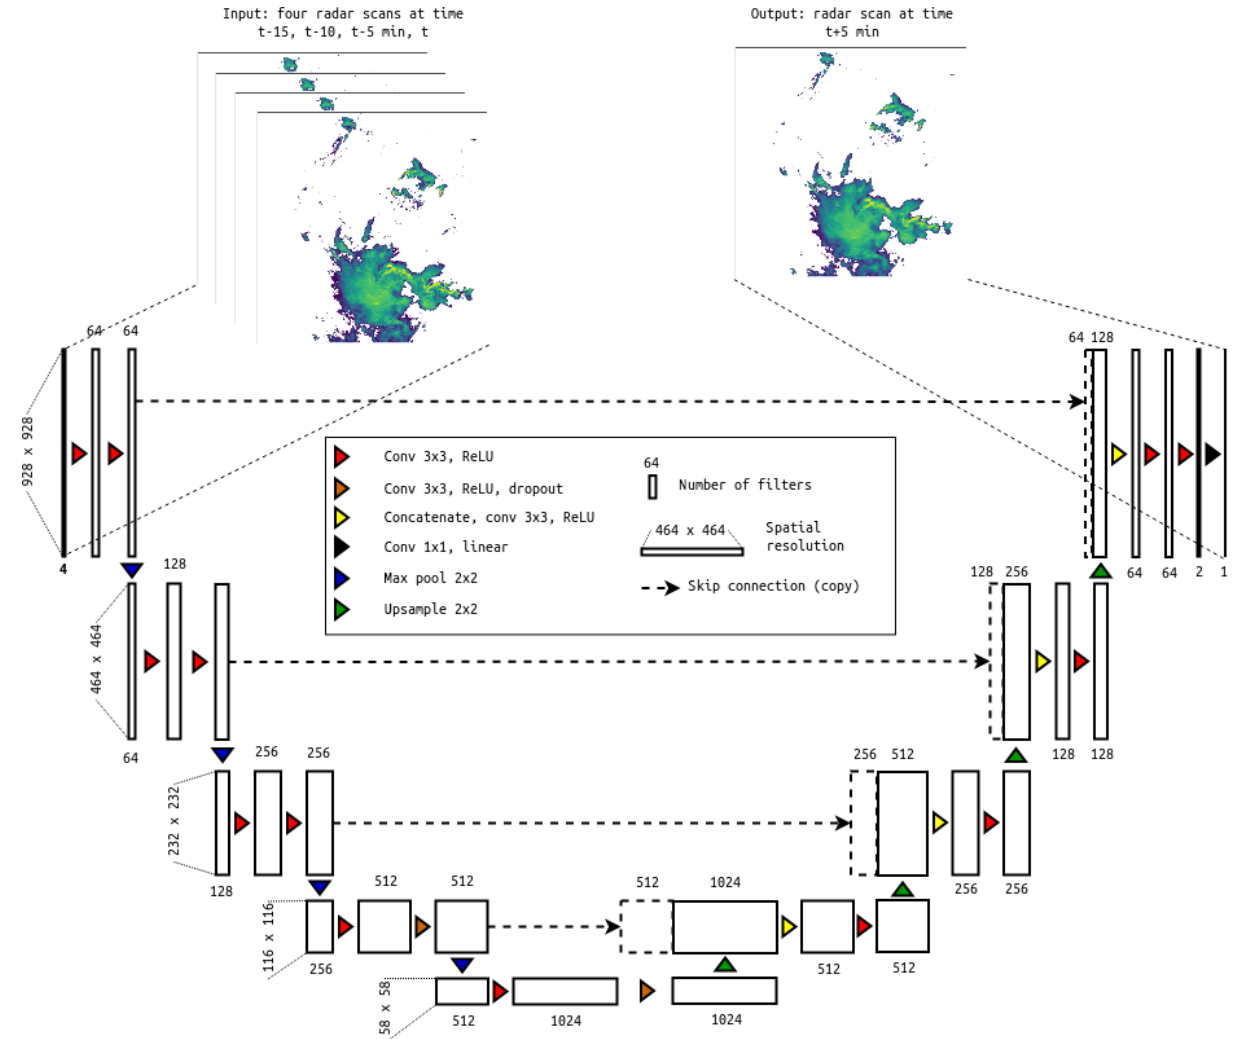
Figure 1. Illustration of the RainNet architecture. RainNet is a convolutional deep neural network which follows a standard encoder–decoder structure with skip connections between its branches. See main text for further